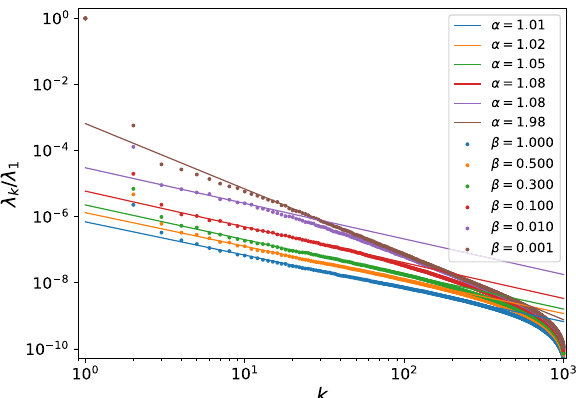
1 maintains in the k − ∼